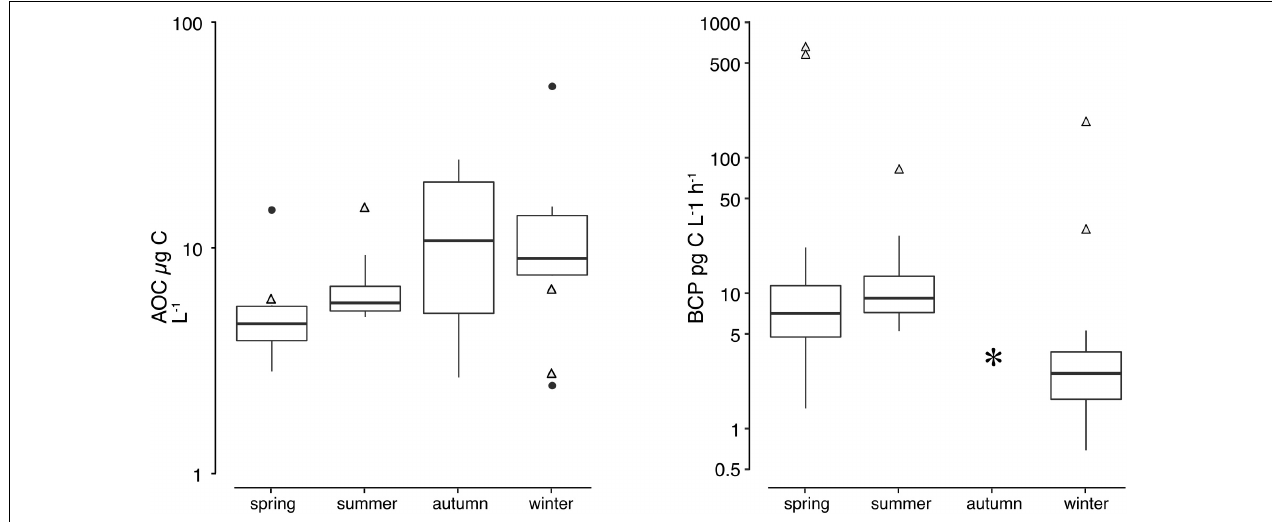
FIGURE 4 | Temporal variation for AOC and BCP. Comparison of the assimilable organic carbon and bacterial carbon production. Triangles represent values measured from the Isar river water.